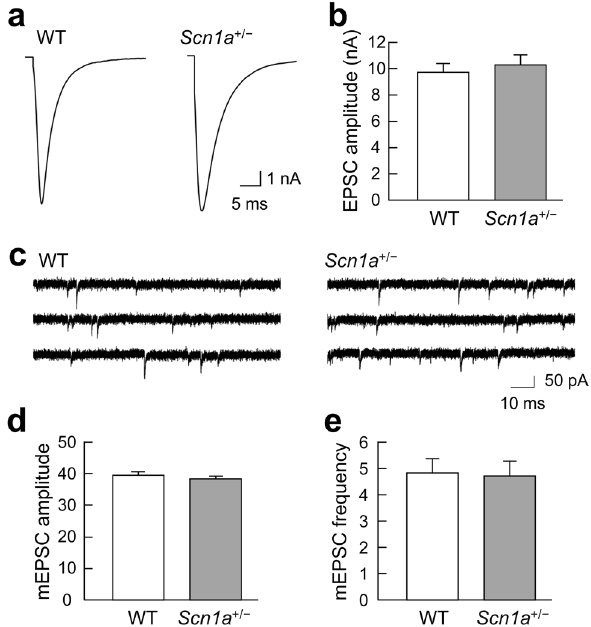
Figure 2. No changes in the excitatory synaptic transmission of Scn1a +/− neurons. ( a ) Representative traces of evoked excitatory postsynaptic currents (EPSCs) recorded from a single autaptic hippocampal neuron of either wild-type (WT) or Scn1a +/− mice. Depolarization artifacts caused by the generated action currents have been removed for clarity of presentation. ( b ) Average amplitudes of the evoked EPSCs in neurons of WT or Scn1a +/− mice (WT: 9.65 ± 0.62 nA, n = 104; Scn1a +/− : 10.25 ± 0.69 nA, n = 102/ N = 5 cultures). ( c ) Representative miniature EPSC (mEPSC) traces in neurons of either WT or Scn1a +/− mice. ( d ) Average mEPSC amplitudes in neurons of either WT or Scn1a +/− mice (WT: 39.47 ± 0.87 pA, n = 104; Scn1a +/− : 38.15 ± 0.71 pA, n = 102/ N = 5 cultures). ( e ) Average mEPSC frequencies in neurons of either WT or Scn1a +/− mice (WT: 4.82 ± 0.52 Hz, n = 104; Scn1a +/− : 4.70 ± 0.56 Hz, n = 102/ N = 5 cultures). Data were obtained from the same autaptic neurons as in ( d